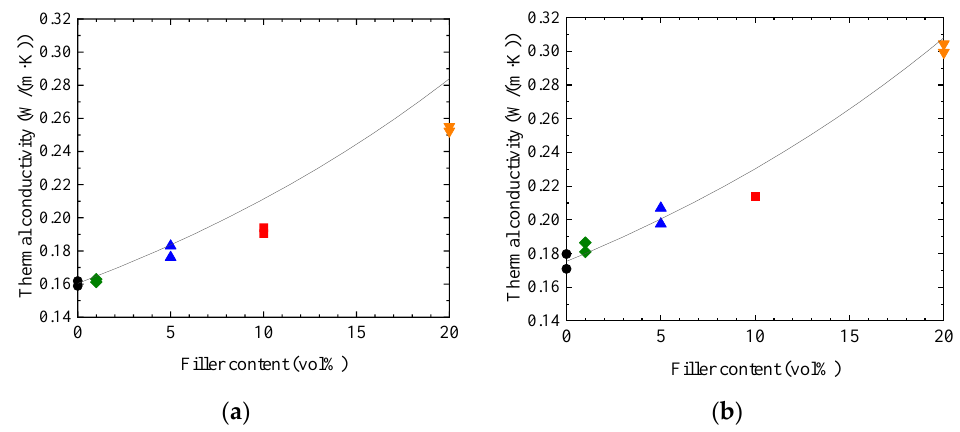
Figure 2. Thermal conductivity as a function of filler content, measured in epoxy NC samples with 100-nm silica. For the sample symbols, refer to Table 1. Several data overlap each other. ( a ) 25 °C, ( b ) 100 °C.